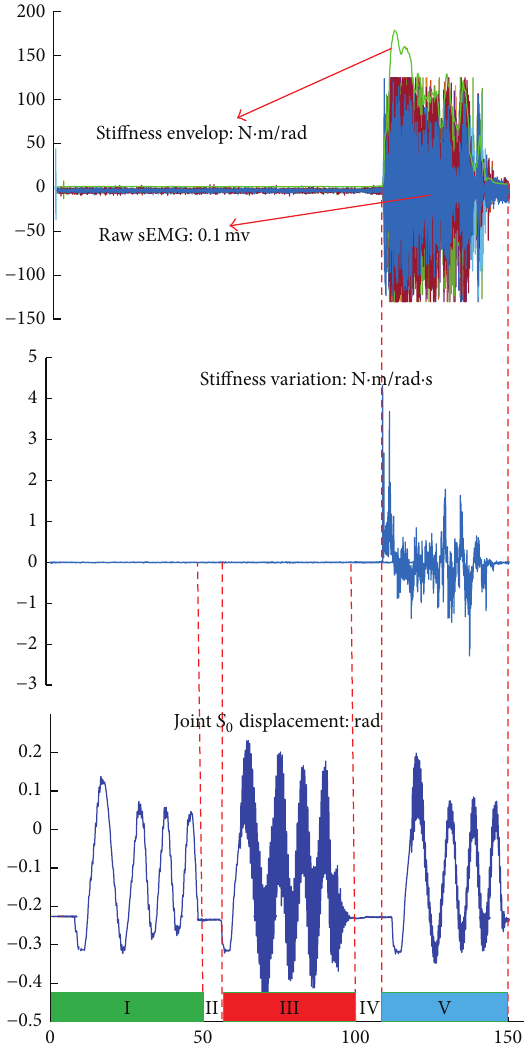
Figure 15: Antidisturbance control under path following